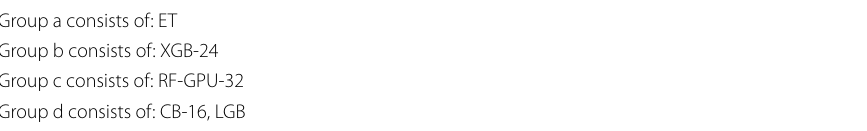
Table 36 HSD test groupings after ANOVA of AUPRC for the CLF